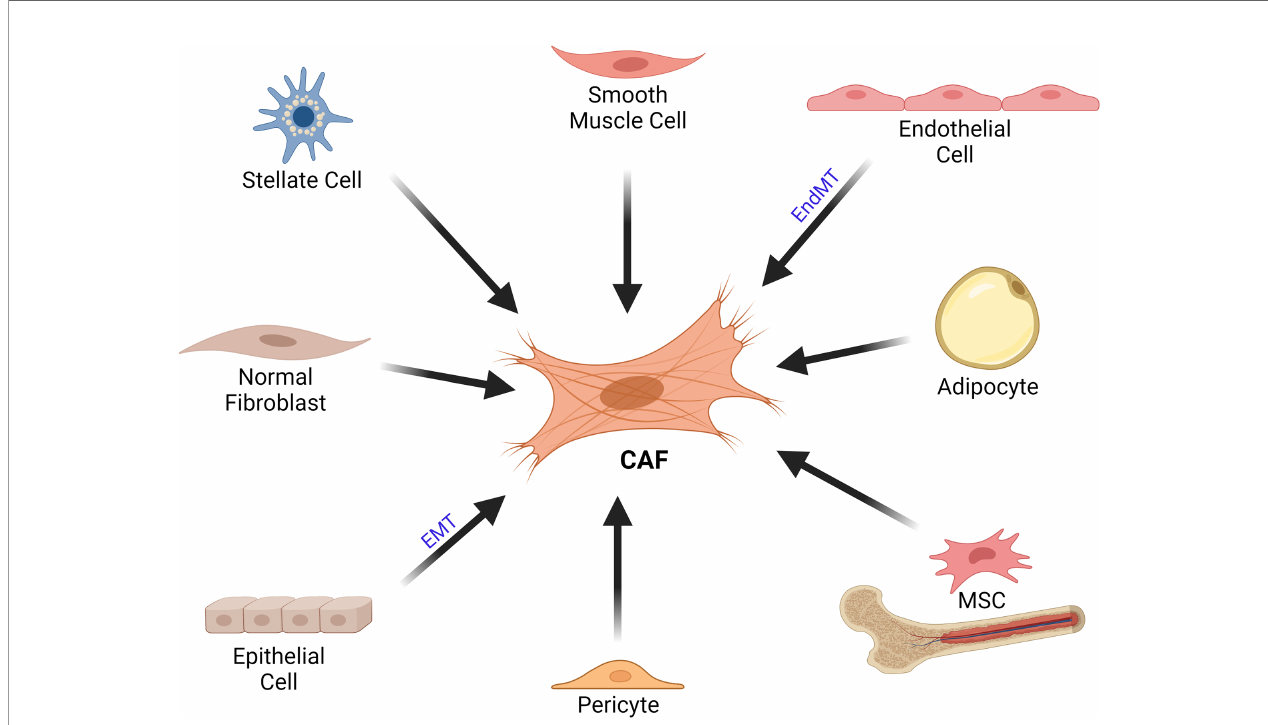
FIGURE 1 | Cellular Origins of CAFs. CAFs can originate from various cell types such as stellate cells, smooth muscle cells, endothelial cells, adipocytes, MSCs, pericytes, epithelial cells as well as normal fi broblasts. CAF, cancer associated fi broblast; EMT, epithelial-mesenchymal transition; EndMT, endothelial to mesenchymal transition; MSC, mesenchymal stem